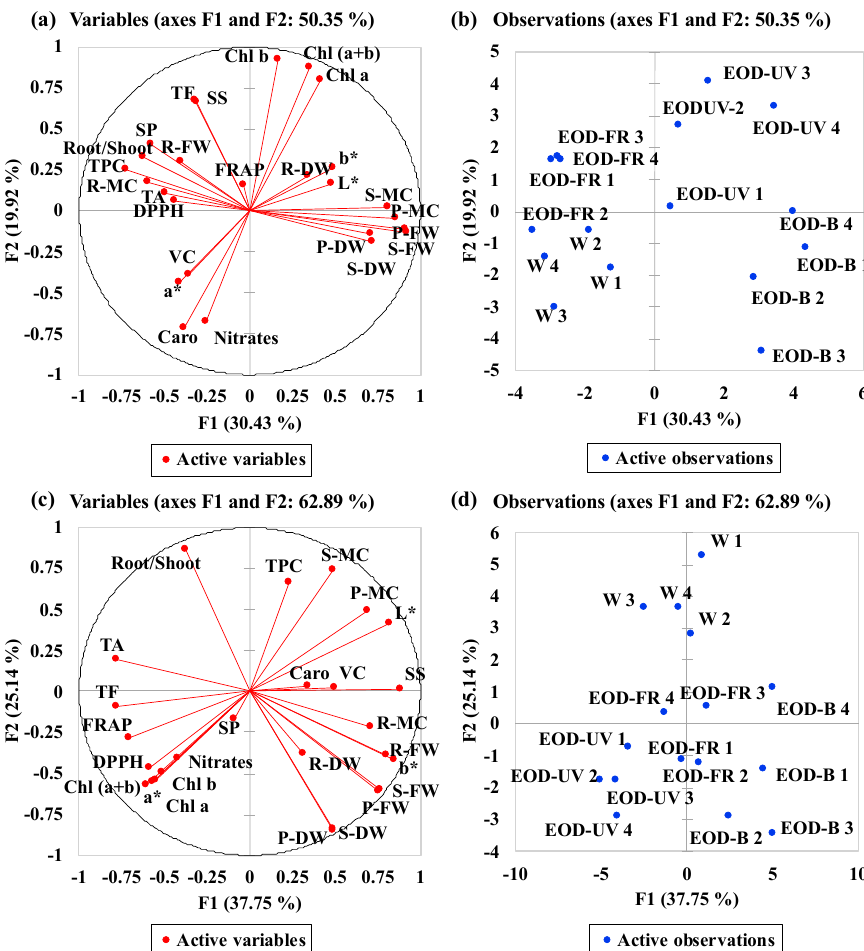
Figure 8. Multivariate principal component analysis showing the effects of end-of-day lightings on lettuce. ( a ) Correlation circle of ‘Red butter’ and ( c ) correlation circle of ‘Green butter’, summarizing indices relations between investigated parameters under different lighting treatments. ( b ) PCA scatter plot of ‘Red butter’ and ( d ) PCA scatter plot of ‘Green butter’, indicating distinct responses in lettuce under different lighting treatments. W= day-white light, EOD-B = end-of-day enhanced blue light, EOD-FR = end-of-day far-red light, EOD-UV = end-of-day ultraviolet-A light. FW = fresh weight, DW = dry weight, MC = moisture content, P- = plant-, S- = shoot-, R- = root-. Chl = chlorophyll, TA = total anthocyanins, Caro = carotenoids. DPPH = DPPH radical inhibition percentage, FRAP = ferric ion reducing antioxidant power, TPC = total phenolic compounds, TF = total flavonoids, VC = vitamin C, SP = soluble proteins, SS = soluble sugars.